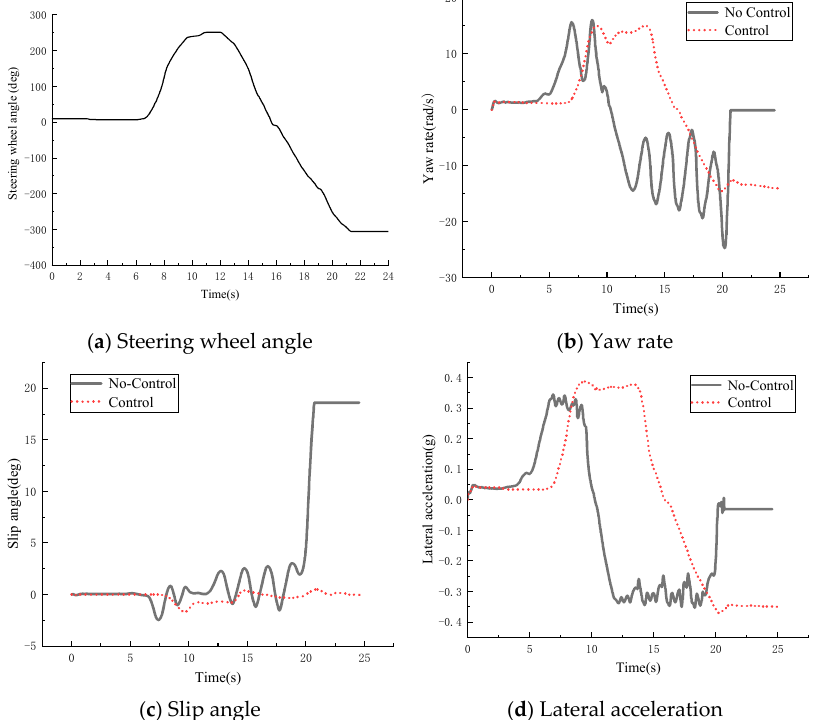
Figure 12. Fishhook. Figure 12.